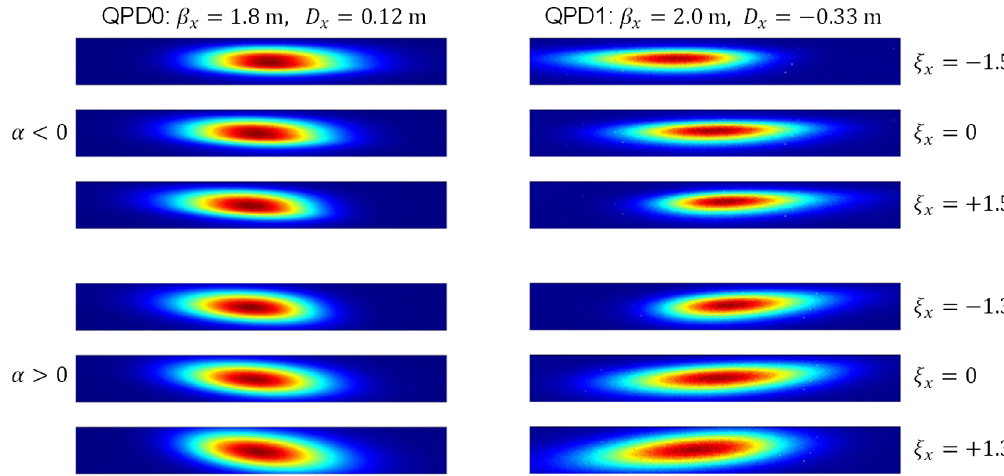
FIG. 2. Transverse beam intensity distortion from Gaussian at dispersive locations due to a nonvanishing horizontal chromaticity measured by the imaging systems installed at QPD0 and QPD1. Three different ξ x are applied in both the negative and positive- momentum-compaction modes with α ¼ (cid:2) 8 . 4 × 10 − 5 . There is some residual horizontal-vertical coupling in the positive-momentum- compaction case, which do not influence the principle observation of the non-Gaussian behavior.